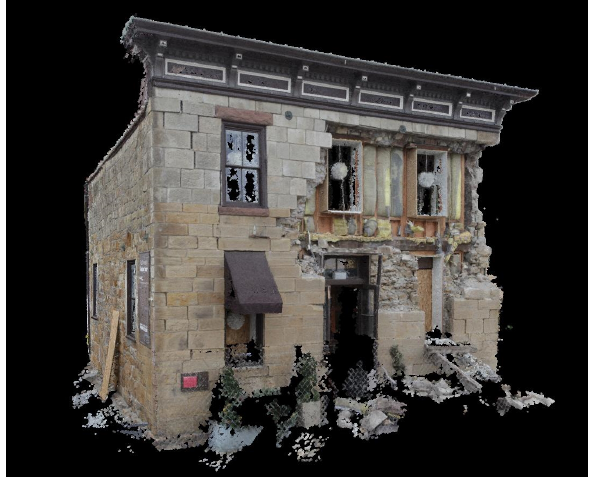
Figure 1. Photogrammetric point cloud in visualization engine